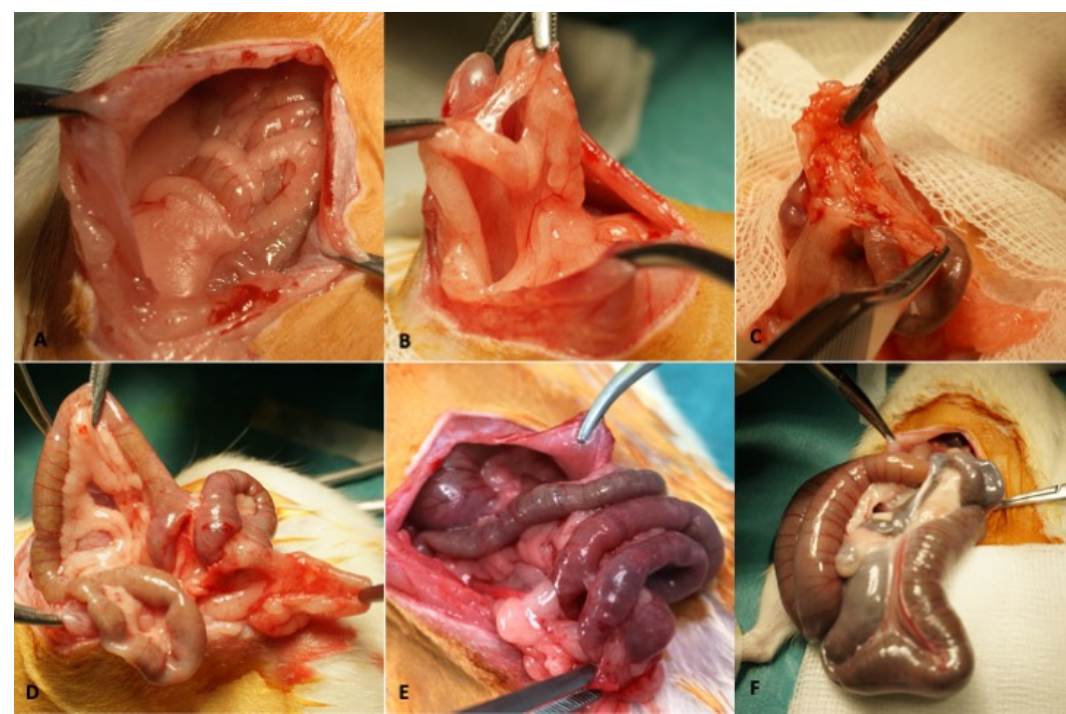
Figure 2. Type of adhesions. ( A ): Type 0; ( B ): Type 1; ( C , D ): Type 2; ( E ): Type 3; ( F ): Type.